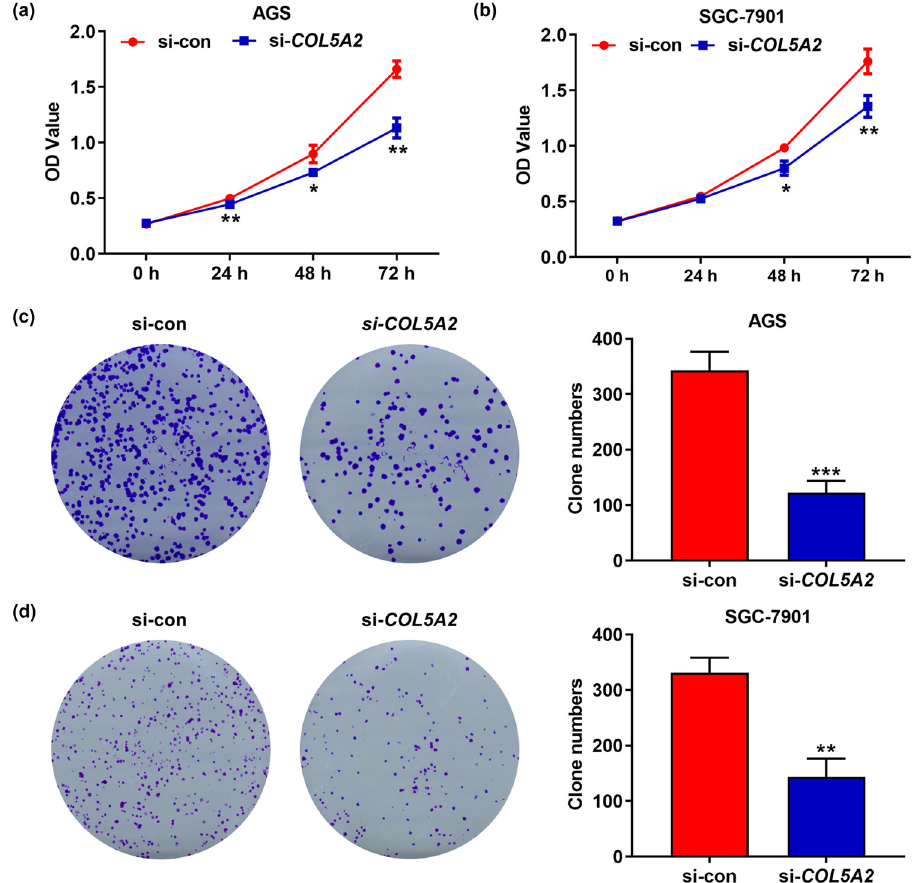
Figure 5: Knockdown of COL5A2 inhibited proliferation of GC cells. ( a and b ) OD values in si - COL5A2 - or si - con - transfected GC cell lines including AGS ( a ) and SGC - 7901 ( b ) were determined by CCK - 8 assay. ( c and d ) Colony numbers of si - COL5A2 - or si - con - transfected GC cell lines including AGS ( c ) and SGC - 7901 ( d ) were analyzed by colony formation assay. * P < 0.05, ** P < 0.01 and *** P < 0.001 vs si - con